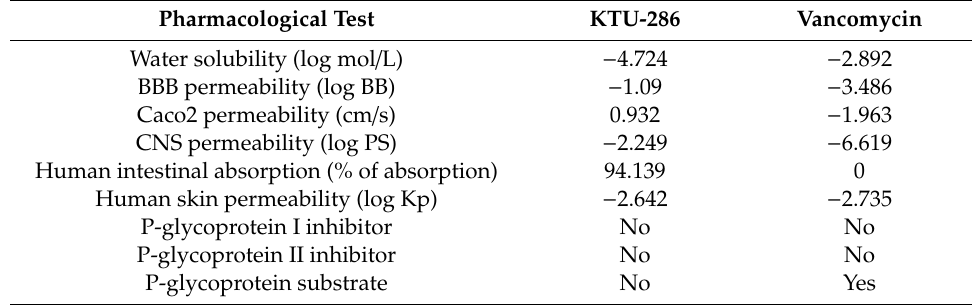
Table 1. The in silico pharmacological permeability characteristics of KTU-286 predicted using pkCSM software .